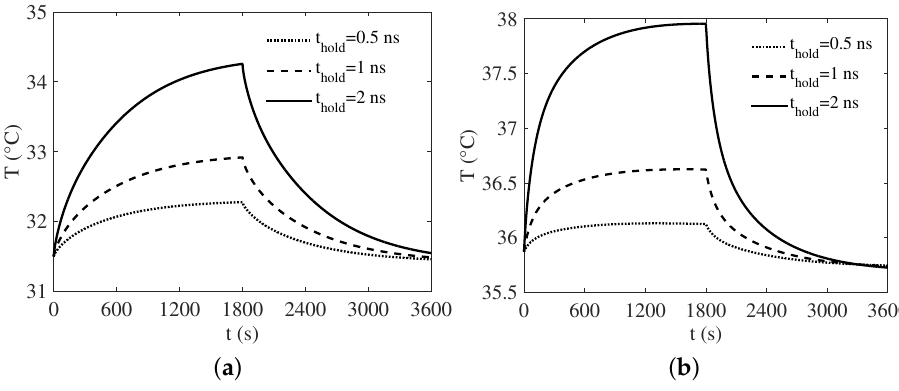
Figure 8. Temperature versus time for three different PEF durations; ( a ) at the air-skin boundary and ( b ) at the outer surface of the brain